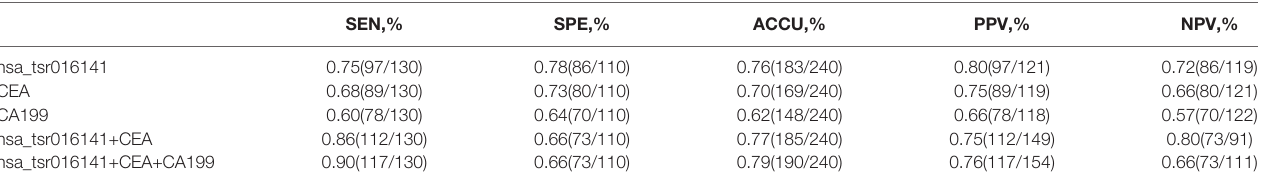
TABLE 2 | Use the expression levels of hsa_tsr016141, CEA, and CA199 to distinguish GC patients from healthy donors. SEN,%